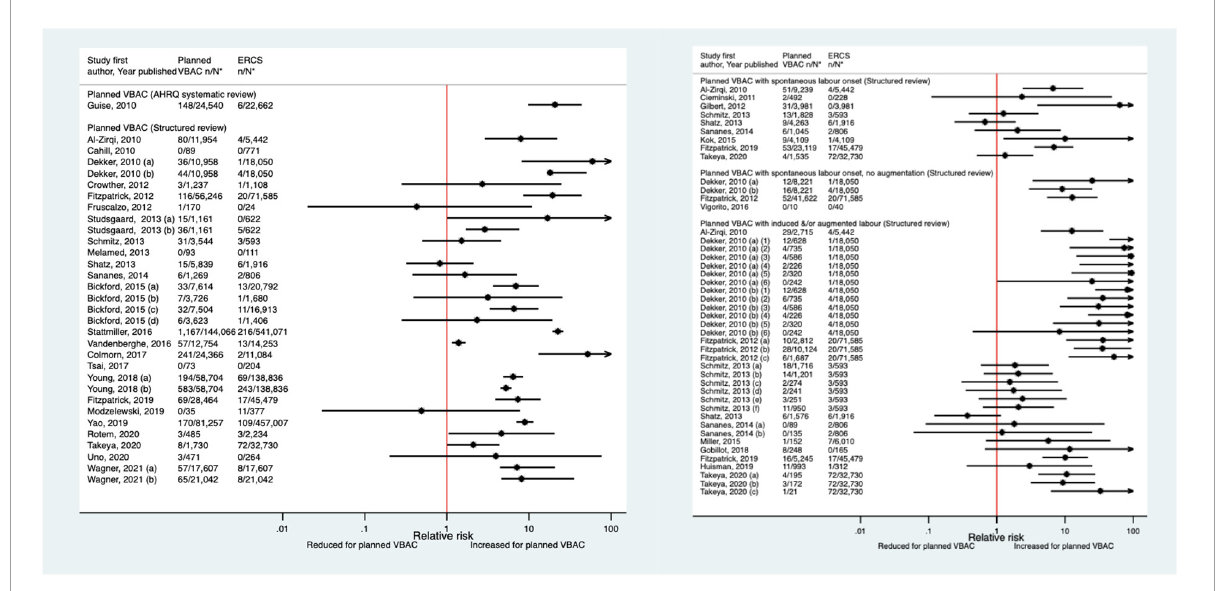
FIGURE1 Risk of uterine rupture for planned VBAC vs. ERCS. * n , number in group with the outcome; N , Total number in group. Dekker et al. (36) (a) outcome: complete uterine rupture, (b) outcome: partial uterine rupture, (1) planned VBAC with spontaneous onset of labor, augmentation with oxytocin, (2) planned VBAC with induced labor onset, oxytocin only, (3) planned VBAC with induced labor onset, prostaglandins only, (4) planned VBAC with induced labor onset, oxytocin and prostaglandins, (5) planned VBAC with induced labor onset, no oxytocin or prostaglandins, (6) planned VBAC with induced labor onset, unspecified method; Studsgaard et al. (48) (a) Outcome: complete uterine rupture, (b) Outcome: incomplete uterine rupture; Bickford and Janssen (50) (a) risk in women with 1–2 prior CSs only, (b) risk in women with 1–2 prior CSs & ≥ 1 prior VB, (c) risk in women with 1 prior CS only, (d) risk in women with 1 prior CS and ≥ 1 prior VB; Young et al. (64) (a) outcome: uterine rupture not including dehiscence, (b) outcome: uterine rupture including dehiscence; Fitzpatrick et al. (78) (a) planned VBAC where labor induced with prostaglandin and oxytocin not used in labor, (b) planned VBAC where labored without prostaglandin induction but oxytocin used in labor, (c) planned VBAC where labor induced with prostaglandin and oxytocin used in labor; Schmitz et al. (46) (a) planned VBAC with induction or augmentation of labor, (b) planned VBAC with oxytocin only, (c) planned VBAC with prostaglandins only, (d) planned VBAC with prostaglandins and oxytocin, (e) planned VBAC where labor induced with oxytocin, (f) planned VBAC where labor augmented with oxytocin; Sananes et al. (49) (a) planned VBAC where labor induced with oxytocin and amniotomy, (b) planned VBAC where induced with Foley catheter; Takeya et al. (73) (a) planned VBAC with induction or augmentation of labor, (b) planned VBAC with induction or augmentation of labor with oxytocin, (c) planned VBAC with induction or augmentation of labor with any prostaglandins with or without oxytocin. AHRQ, Agency for Healthcare Research and quality; CS, cesarean section; ERCS, elective repeat cesarean section; VBAC, vaginal birth after previous cesarean; VB, vaginal